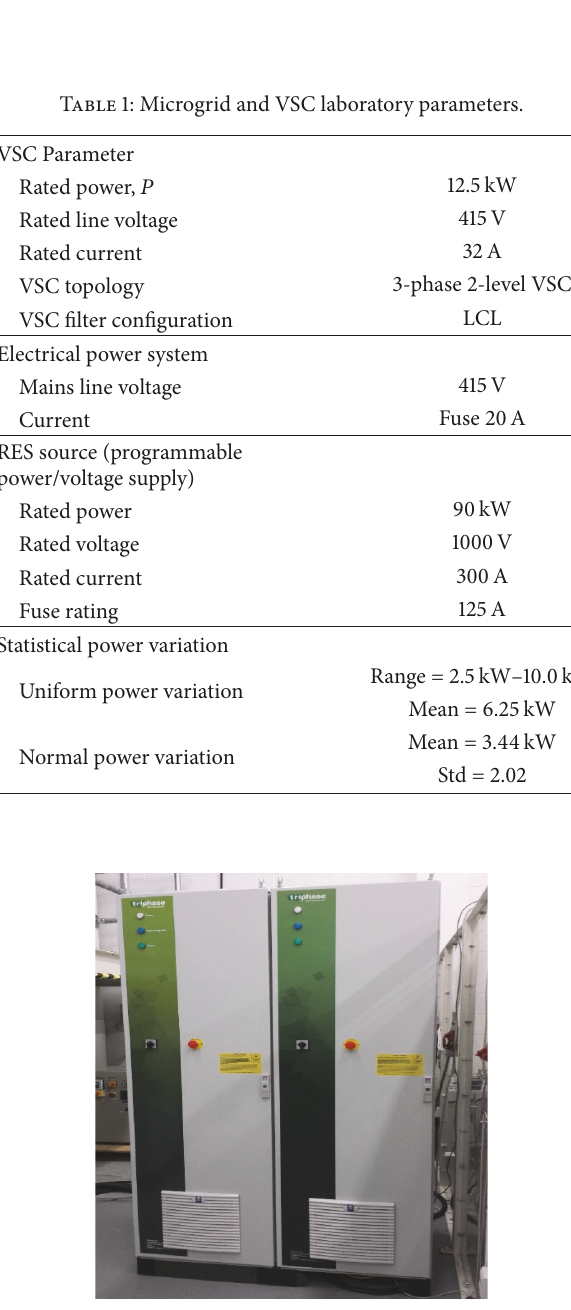
Figure 10: Controllable power and voltage source